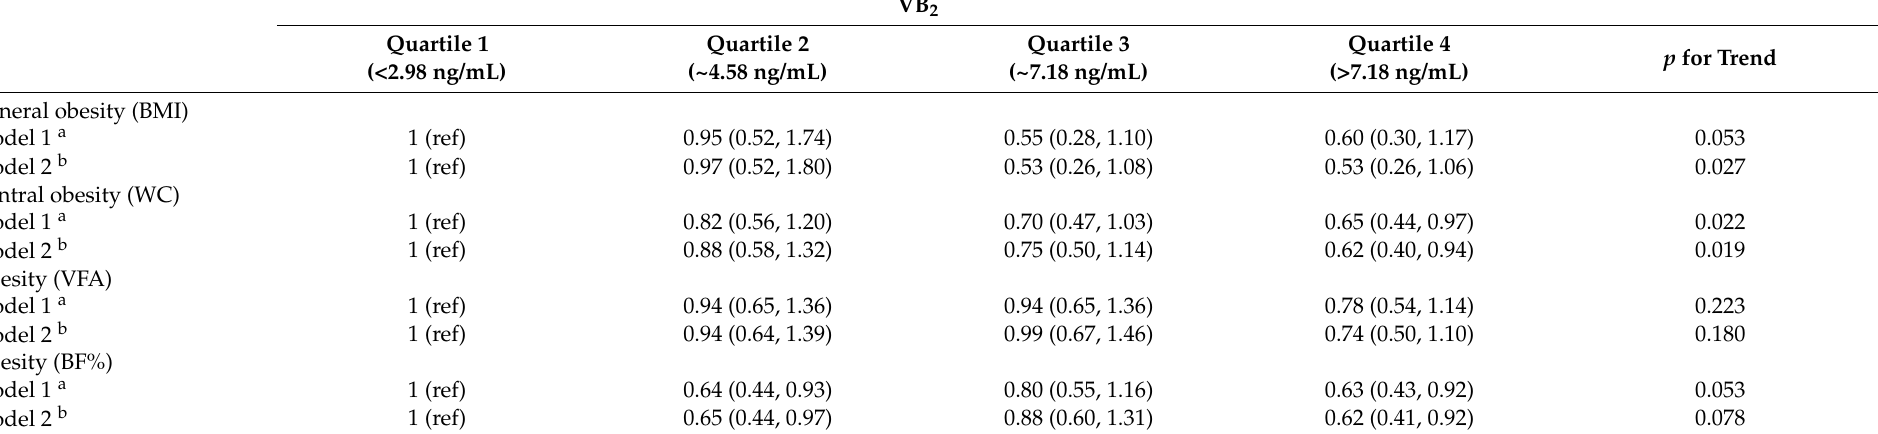
Table 5. Association between vitamin B 2 and obesity according to different obesity definitions.